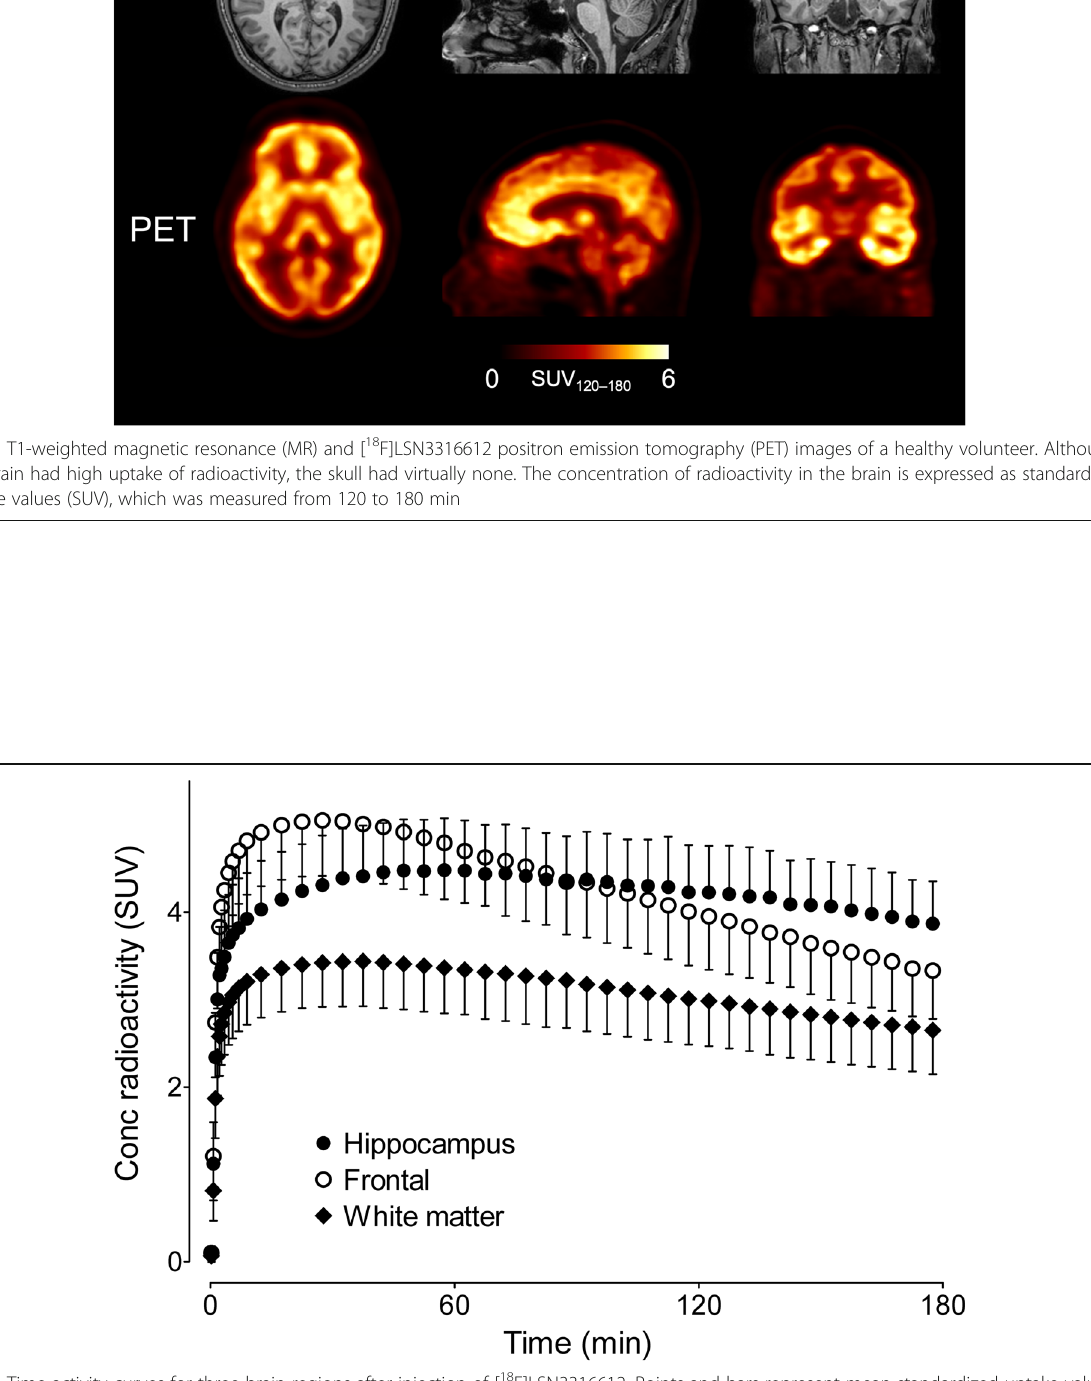
Fig. 2 Time-activity curves for three brain regions after injection of [ 18 F]LSN3316612. Points and bars represent mean standardized uptake values (SUV) and standard deviations (SD), respectively, which were measured from 17 healthy